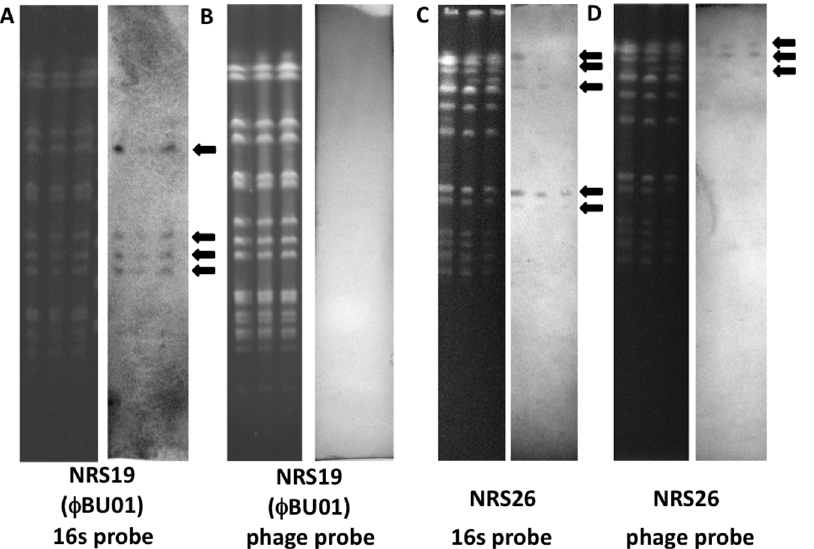
Figure 5. VISA ExP W ’s localize in and outside of the chromosome. S. aureus culture samples were taken at 6, 8 and 24 hours following 1:100 dilution of overnight cultures. Samples were concentrated to an adjusted OD 600 of 5.0 to 10. Chromosomal DNA was prepared inside 0.75% agarose beads and cut with Sma I restriction digestion enzyme. DNA bands separated by PFGE (left in each set) were transferred to a nylon membrane (right in each set) and analyzed by Southern blot. (A and C) Biotin incorporated labeled probe specific to 16S DNA of S aureus DNA encoding 16S ribosomal RNA. (B) Biotin labeled probe specific to an ExP W found in NRS19 ( W BU01) was used for a Southern blot probe on NRS19 cultures. (D) Biotin labeled probe specific to an ExP W found in NRS26 was used for a Southern blot probe on NRS26 cultures. Black arrows indicate location of bands on the Southern blots.